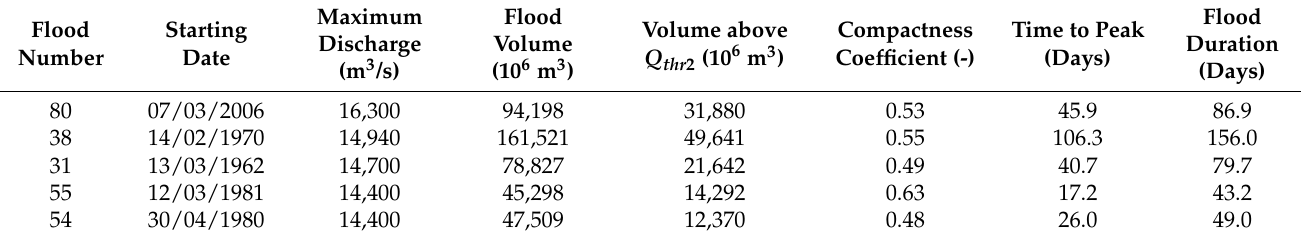
Table 4. Floods at Turnu-M ă gurele gauge station and their parameters.